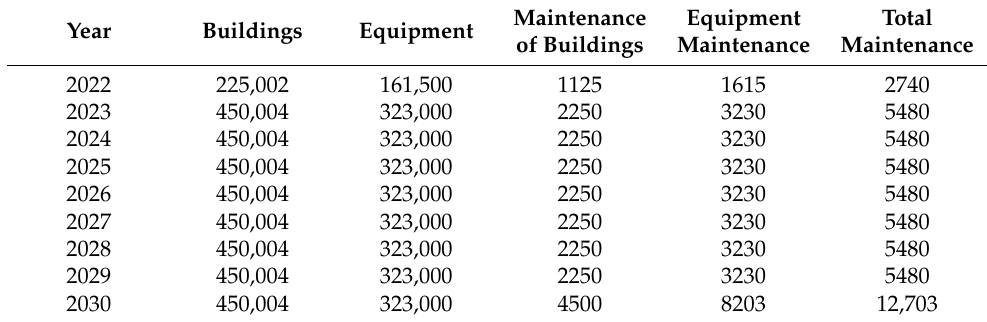
Table 3. Maintenance cost projection (in EUR).